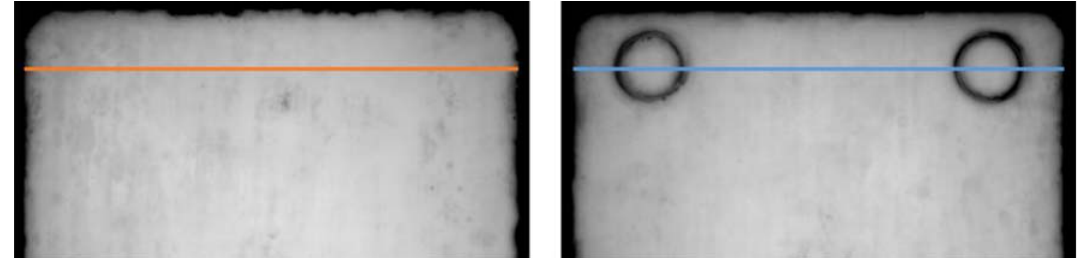
Fig. 3. Averaged iV OC calibrated PL images of wafers handled before (left) and after a-Si deposition (right). With lines as guide to the eye for the following line plots.